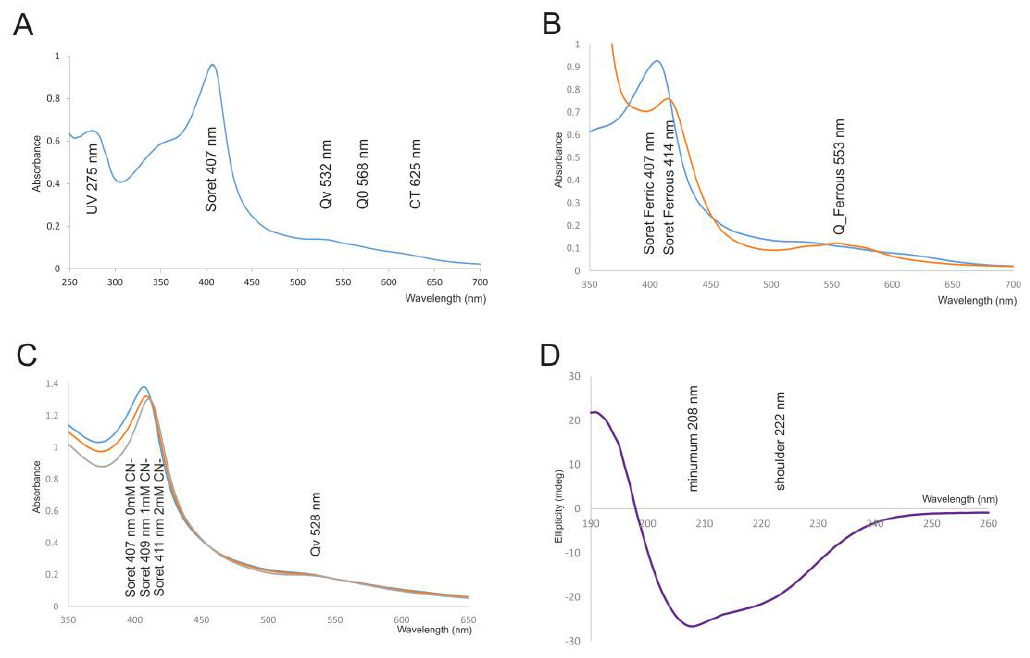
Figure 4. Spectroscopic features of highly purified MoHyBPOX1 heme protein. ( A ) UV-vis spectrum of the purified ferric form with Soret maximum at 407 nm and RZ value of 1.48 revealing a very high level of purity for this heme protein. ( B ) Reduction to ferrous form with the addition of sodium dithionite resulting in a shift of Soret maximum to 414 nm and occurrence of an additional visible band at 553 nm. ( C ) Stepwise titration of purified MoHyBPOX1 with increasing concentration of NaCN leading to a shift in Soret maximum from 407 to 411 nm. ( D ) Far-UV ECD spectrum of affinity purified MoHyBPOX1 protein recorded between 190 and 260 nm with a typical minimum at 208 nm and a shoulder at 222 nm. The content of the secondary structure elements is calculated in Table 2.